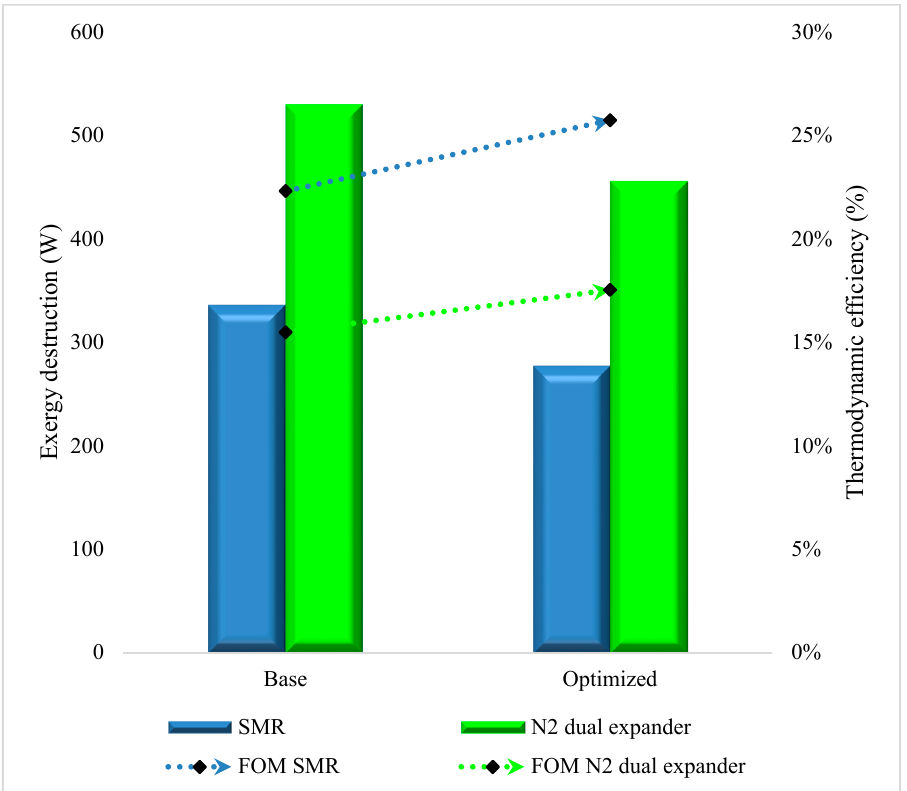
Figure 11. Net exergy destruction comparison in SMR and N 2 dual expander LNG processes and corresponding thermodynamic efficiency.